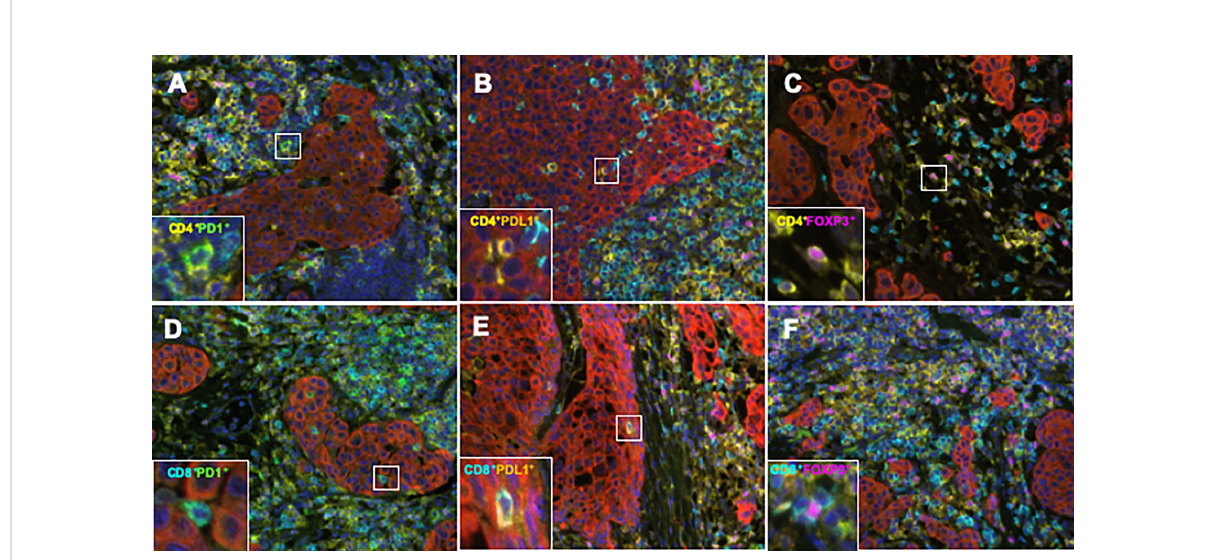
FIGURE 3 Representative TIL marker double-positive cells obtained using an automated quantitative pathology imaging system and image analysis software. (A) CD4 (yellow)/PD1 (green), (B) CD4 (yellow)/PDL1 (orange), (C) CD4 (yellow)/FOXP3 (pink), (D) CD8 (light blue)/PD1 (green), (E) CD8 (light blue)/PDL1 (orange), and (F) CD8 (light blue)/FOXP3 (pink) double positive cells in BC